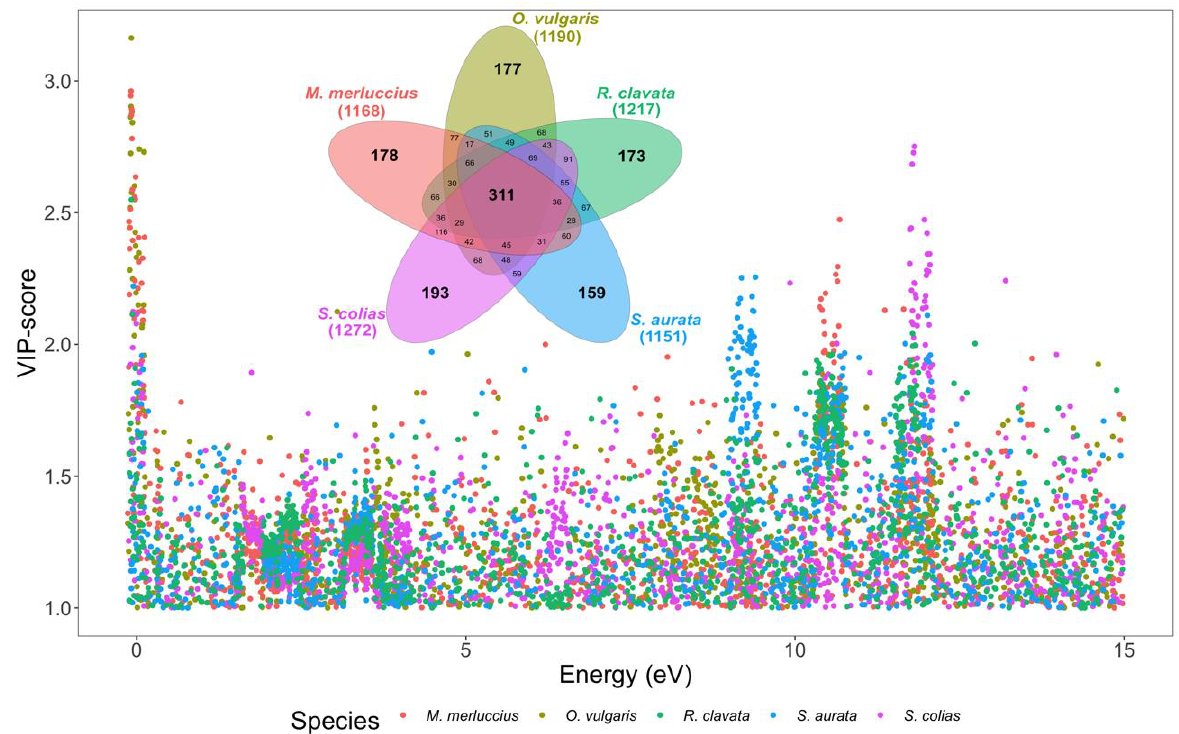
Figure 7. Scatter plot of the VIP scores (only variables with VIP score > 1) attained from the partial least-squares discriminant analysis (PLS-DA) of the processed (Savitzky–Golay first-order differentia- tion filter) X-ray fluorescence reflectance spectra of the Merluccius merluccius , Octopus vulgaris , Raja clavata , Sparus aurata, and Scomber colias samples collected along the Portuguese coast, and Venn diagram of the selected variables (VIP score > 1) between the different analysed species.